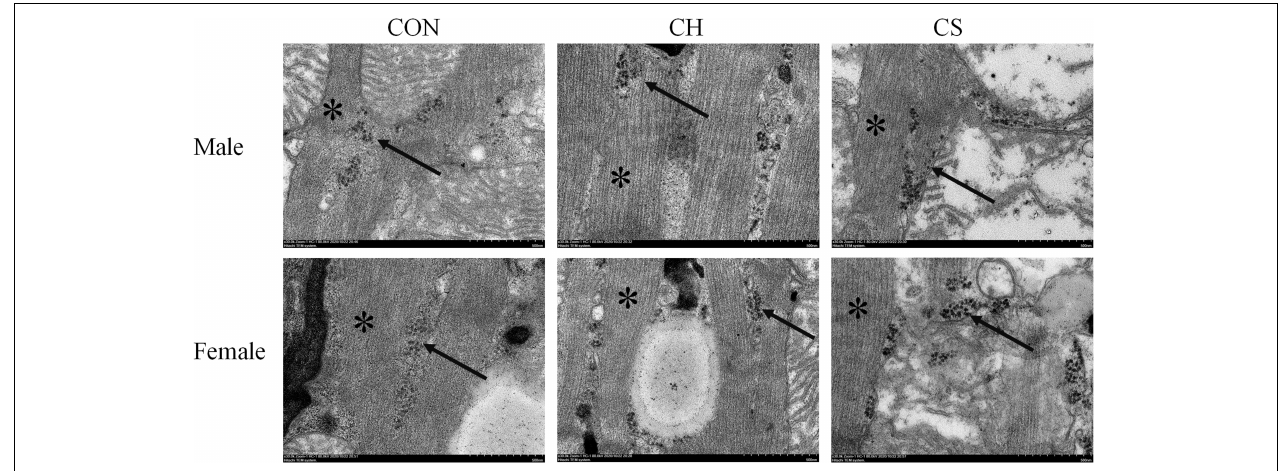
FIGURE 1 | Ultrastructural distribution of myocardial glycogenosomes in Brandt’s voles. Arrow indicates glycogenosome. Muscle filaments (see asterisk) was well arranged. Scale bar = 0.5 µ m.